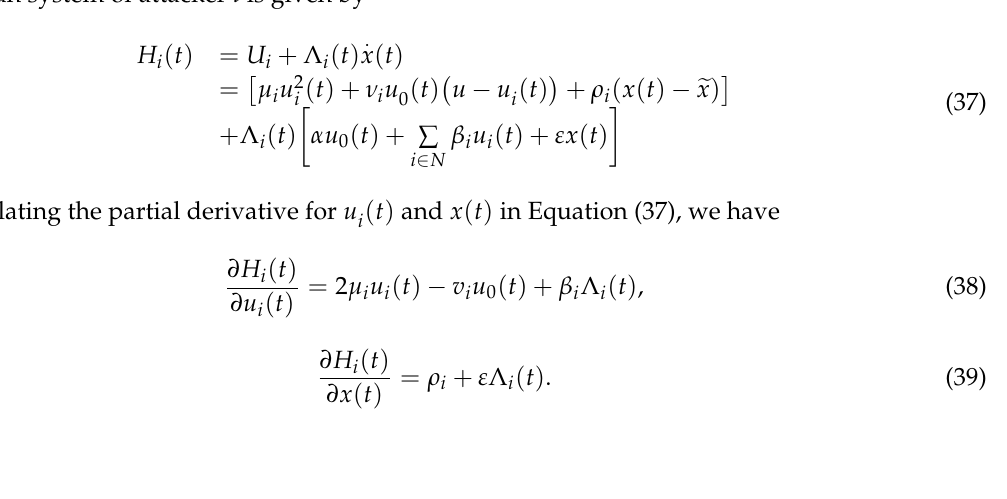
Figure 8. The time complexity of the proposed game model.